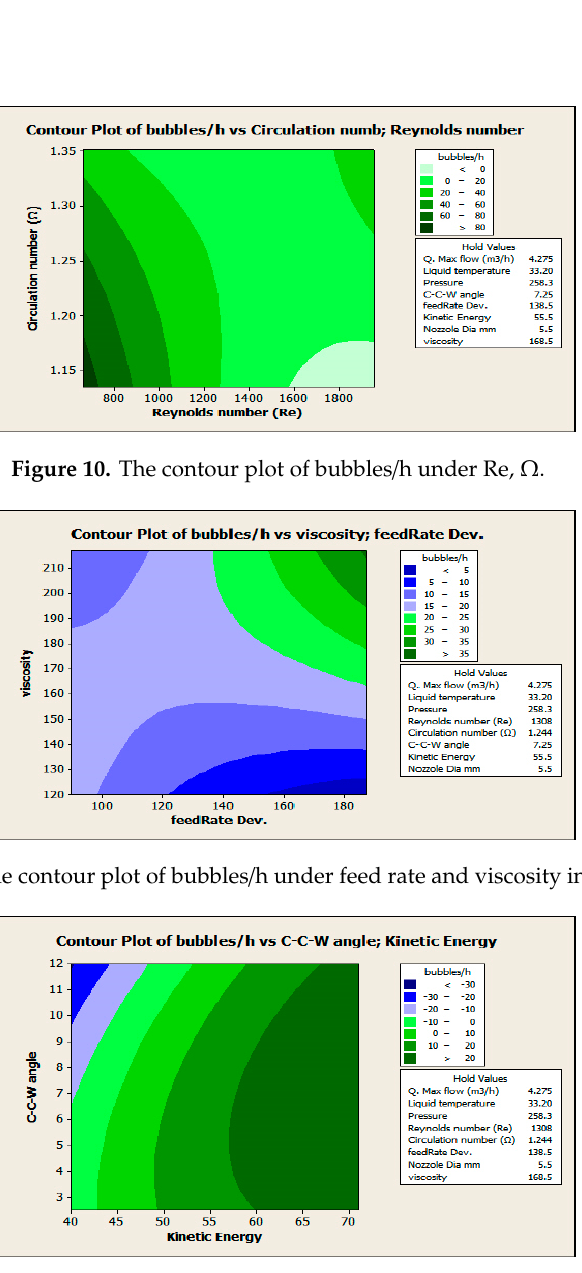
Figure 12. The contour plot of bubbles/h under kinetic viscosity and anti-clockwise angle direction.